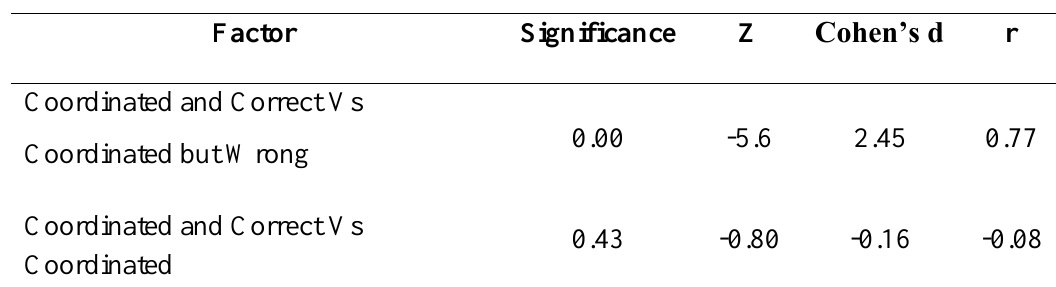
Table 4.10 – The Actual Dyads significance and effect size